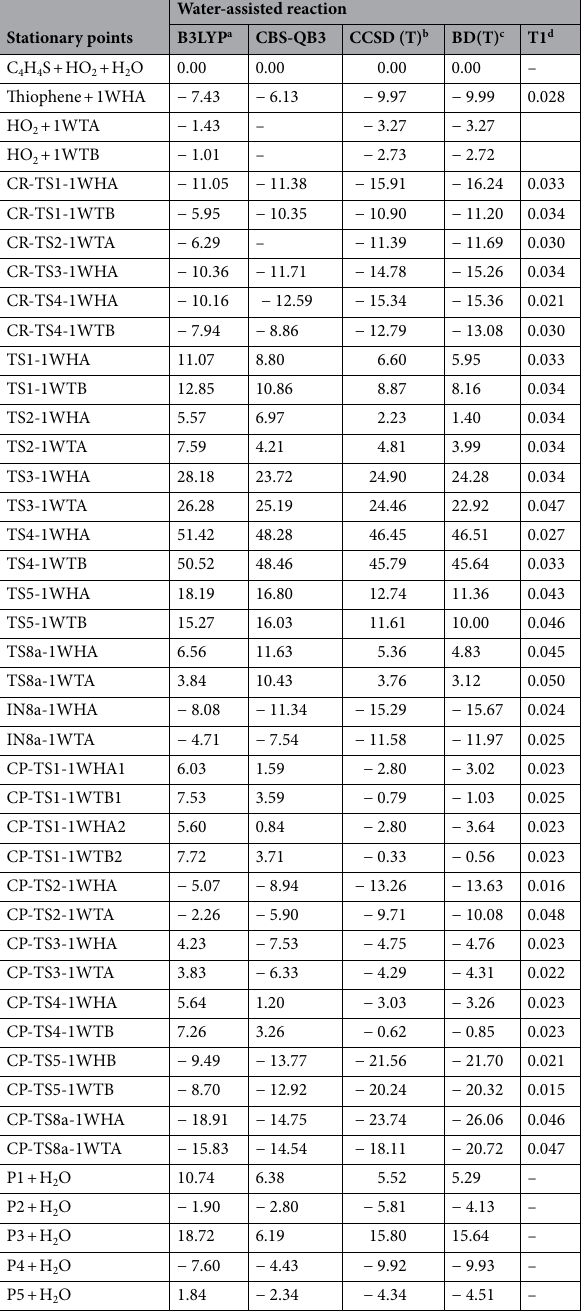
Table 3. Relative energies (in kcal mol −1 ) of the reactants, products, intermediates, and transition states involved in the water-assisted reactions at three different levels of theory. a B3LYP method in conjunction with the 6–31 + G(d,p) basis set. b CCSD(T) single point on the optimized structure of the B3LYP/6–31 + G(d,p) level. c BD(T)/6–31 + G(d,p)//B3LYP/6–31 + G(d,p) level. d T1 diagnostic values at the CCSD(T)/6–31 + G(d,p)